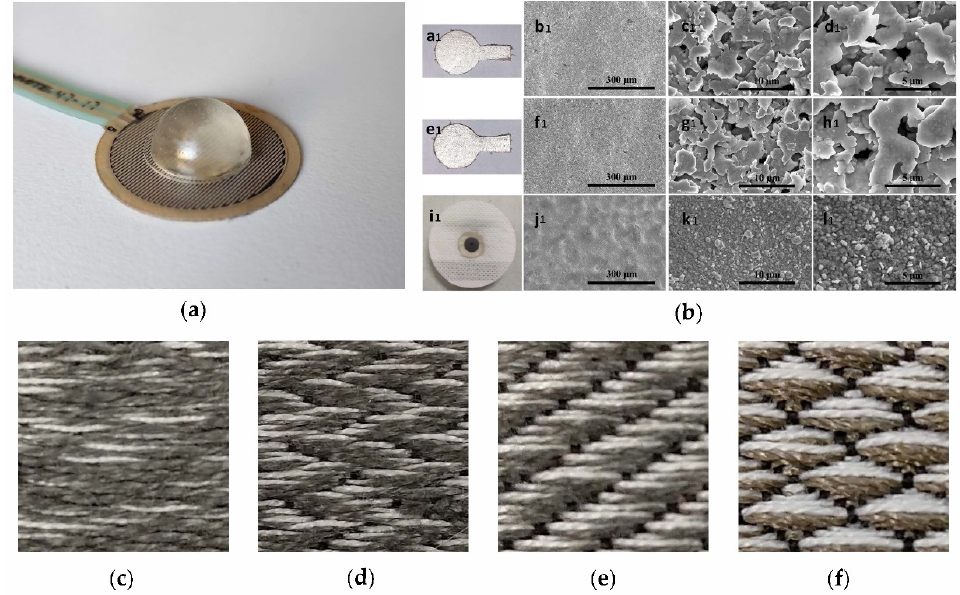
Figure 3. Monitoring sensors of different materials: ( a ) A kind of force-cardiography sensor [26]; ( b ) from a1 to l1, there are three kinds of wearable flexible silver electrodes, including an electrode based on the top grain layer ( a1 – d1 ), split layer ( e1 – h1 ), and the standard Ag/AgCl electrode ( i1 – l1 ) [27]; ( c – f ) show the different weave structures of woven textile electrodes [28].